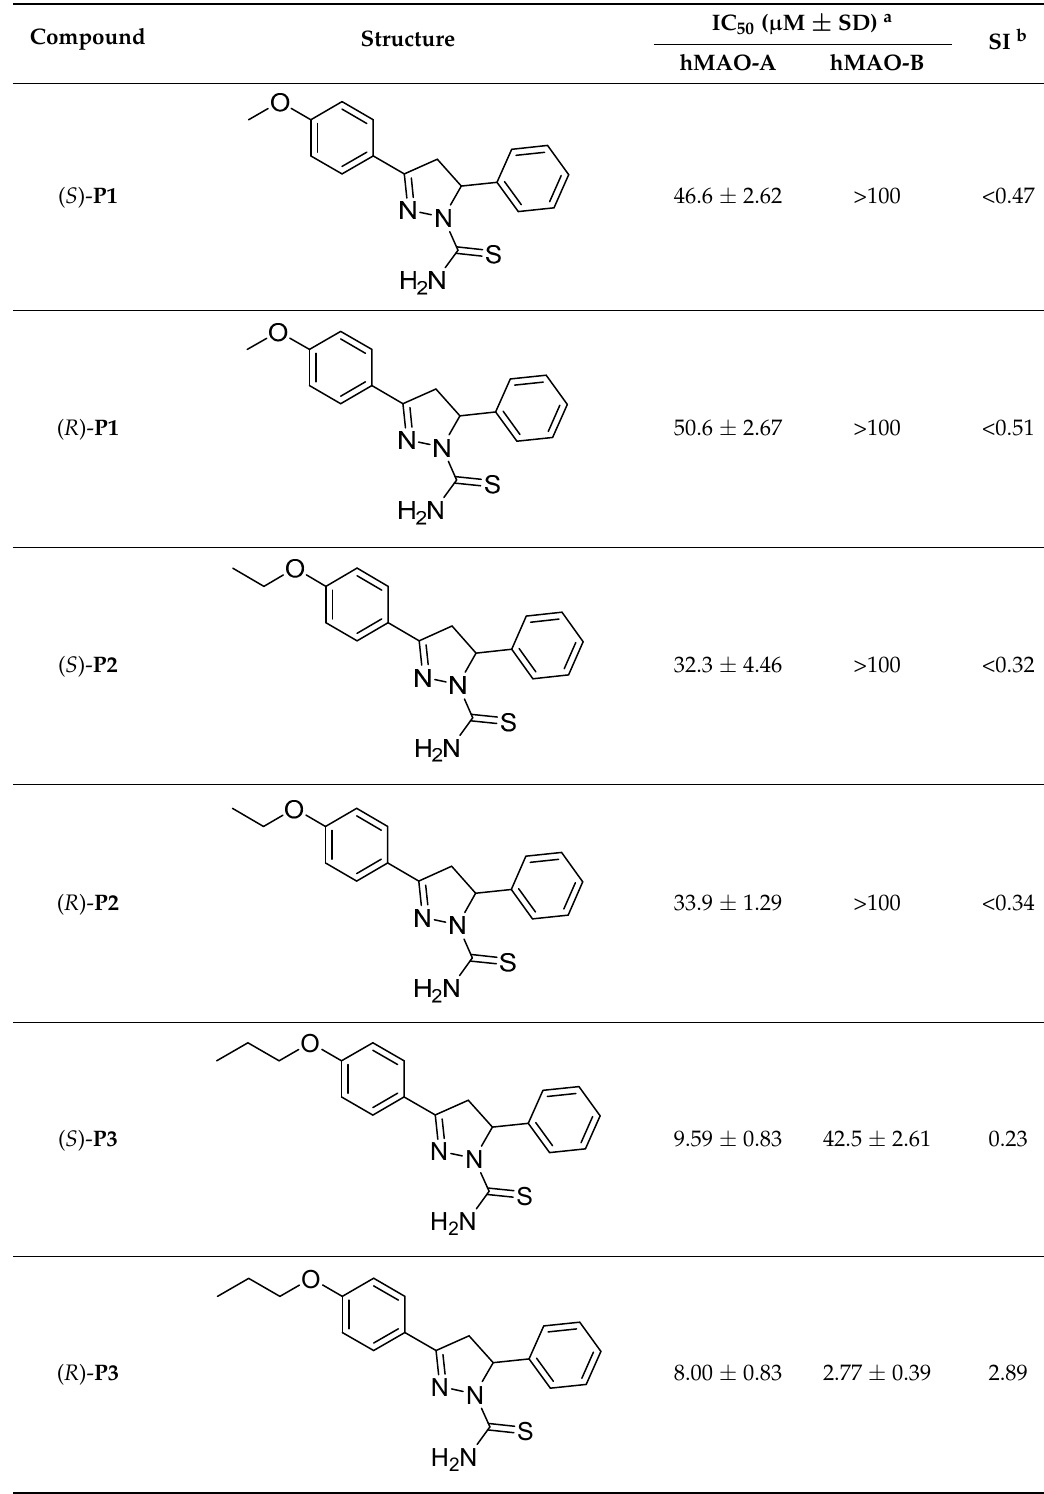
Table 1. Inhibitory activities (IC 50 ) and selectivity index (SI) values of compounds P1 – P18 towards hMAO-A and hMAO-B.